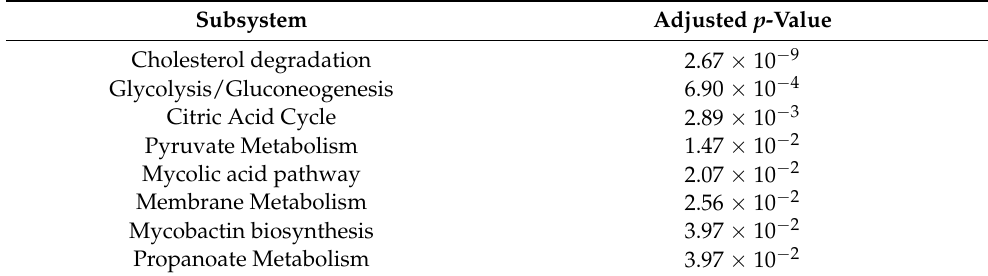
Figure 4. Comparative fluxomics between sampled flux distributions of genome ‐ scale metabolic models of human ‐ and animal ‐ associated lineages. ( A ). Score plot of OPLS ‐ DA (Orthogonal Partial Least Square Discriminant Analysis). The predictive component separates samples of animal ‐ associated models from samples of human ‐ associated models. ( B ). Proportion of reactions fluxes within each one of the altered subsystems positively correlated either to human or animal association (determined by the sign of the loading value of predictive component of each reaction, positive means correlated to human, negative to animal). Table 2. Altered subsystems between animal ‐ and human ‐ associated models . Each model’s flux space was sampled in conditions mimicking Middlebrock 7H9 OADC supplemented with cholesterol. The significantly differential reactions between models of animal ‐ and human ‐ associated lineages were determined with a multivariate analysis (OPLS ‐ DA, VIP ≥ 1.0), and an over ‐ representation analysis was carried out with a Fisher exact test (adjusted p ‐ value < 0.05).